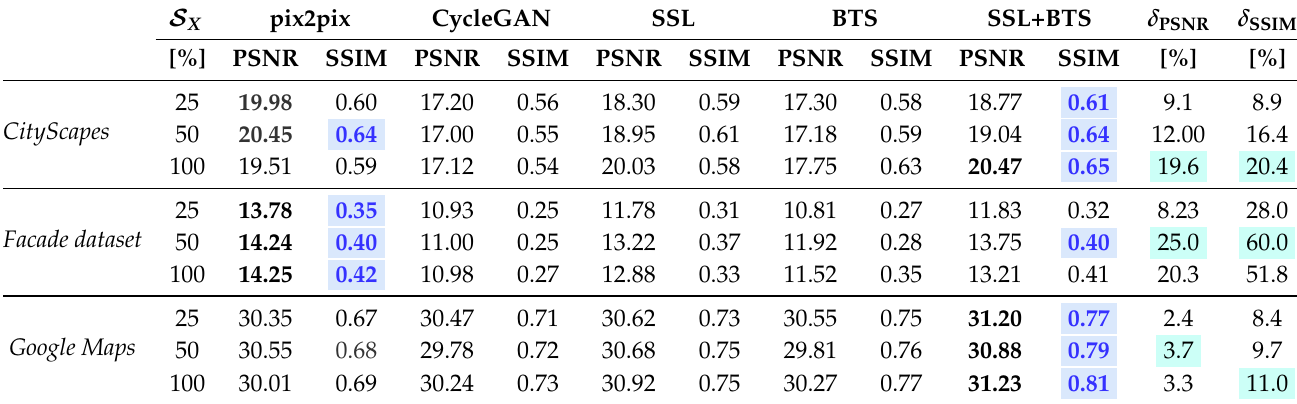
Table 1. Experimental comparison between proposed semi-supervised (SSL+BTS) and the unsuper- vised CycleGAN, under different scenarios: varying sample size S X of scarce domain X , as well as when applied to different tasks/datasets— CityScapes , Facade dataset , Google Maps